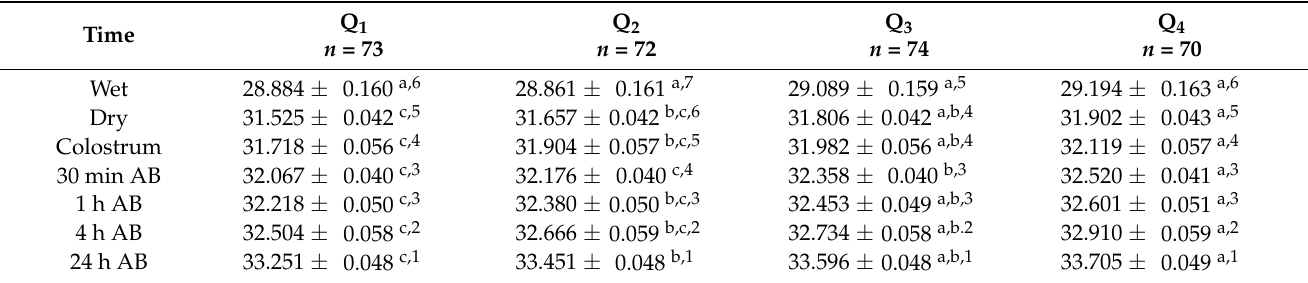
Table 4. Average of the temperature of thoracic (T) window at different times in newborn puppies classified into 4 groups according to